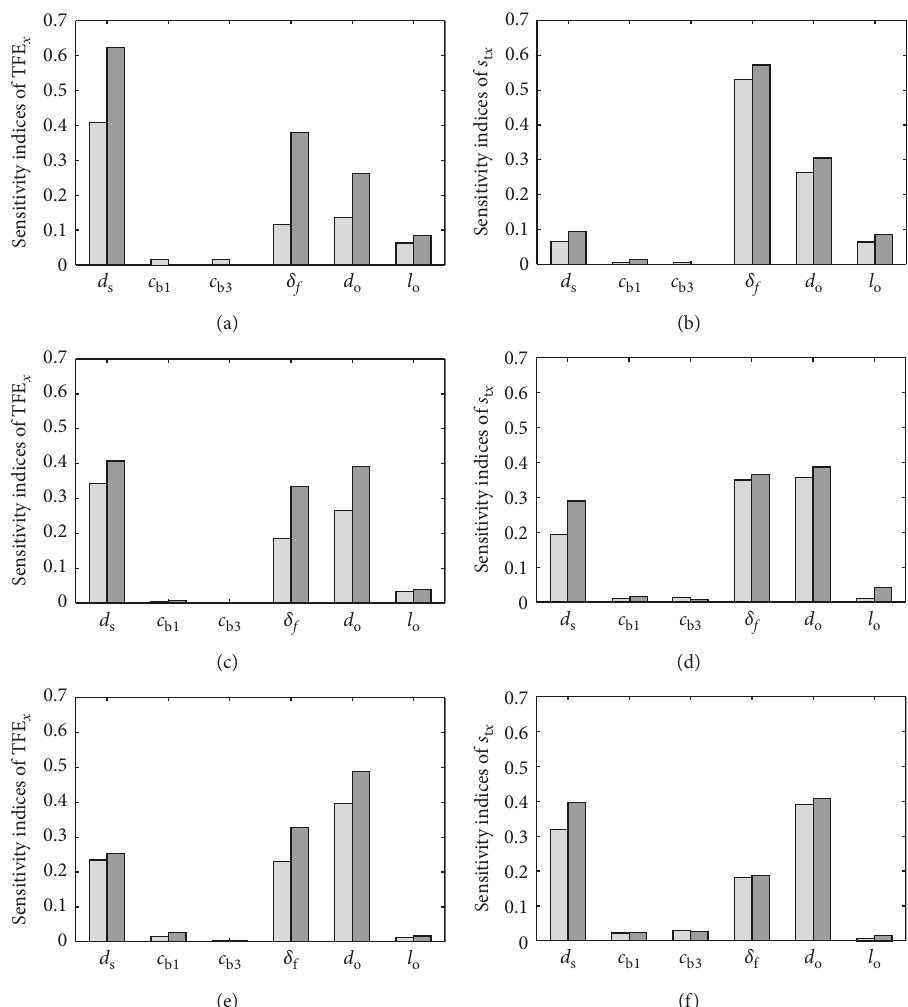
x for different input vibrations: WN1 x (a), for different input vibrations: WN1 x t x